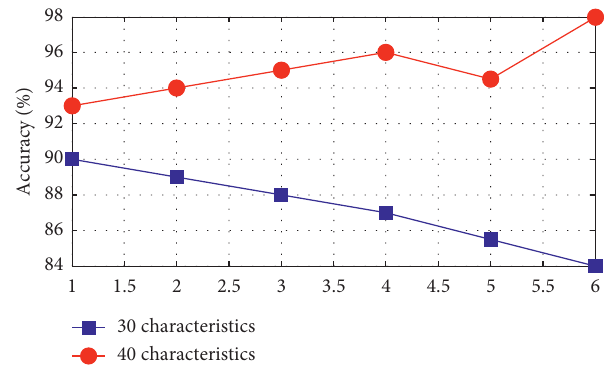
Figure 11: Comparison of the number of hidden layers and the number of nodes of the